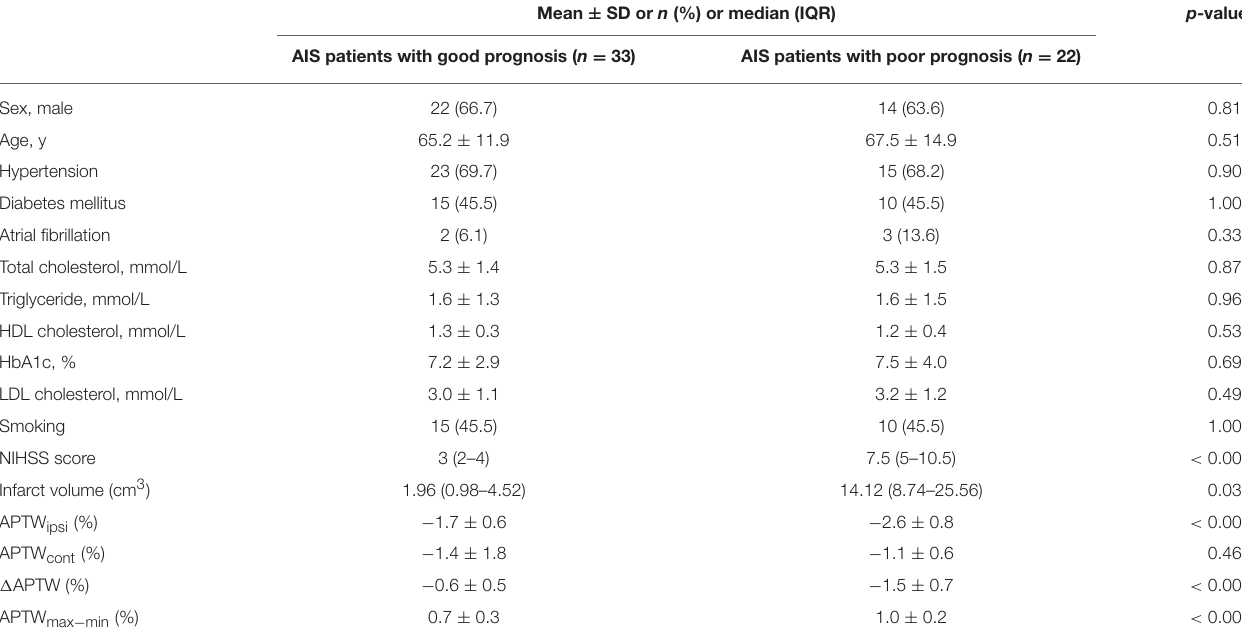
TABLE 2 | Baseline characteristic and multiple APT signal parameters of two groups AIS patients. Mean ± SD or n (%) or median (IQR) AIS patients with good prognosis ( n =